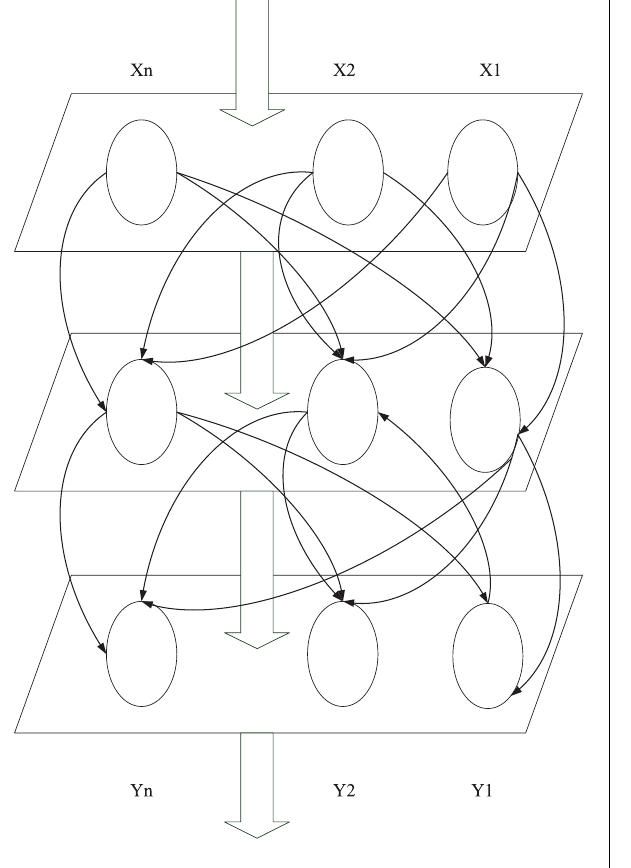
FIGURE 2 | Structure of the simple feedforward hierarchical ANN.